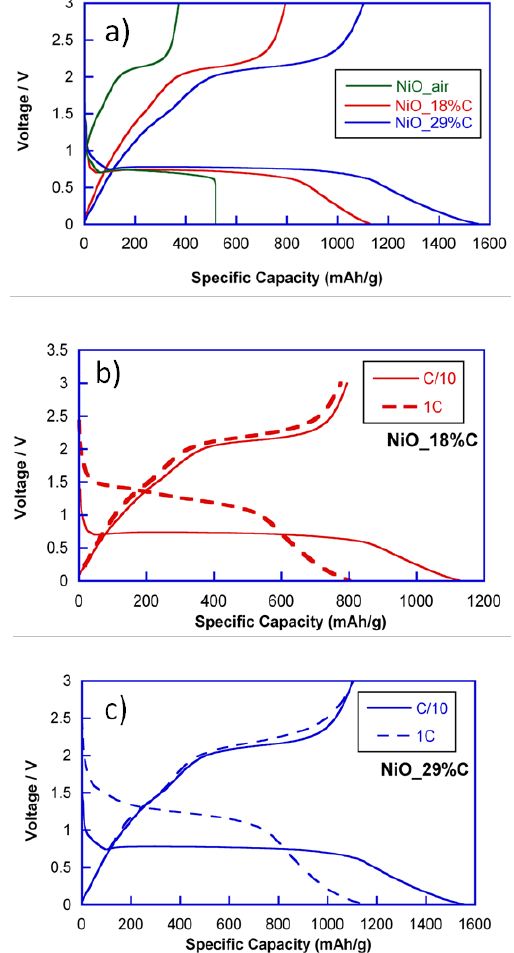
Figure 4. ( a ) First discharge-charge curves for NiO_air, NiO_18%C, and NiO_29%C at C/10, ( b ) comparison of the discharge-charge profiles at C/10 and 1C for NiO_18%C electrode, and ( c ) comparison of the discharge-charge profiles at C/10 and 1C for NiO_29%C electrode.